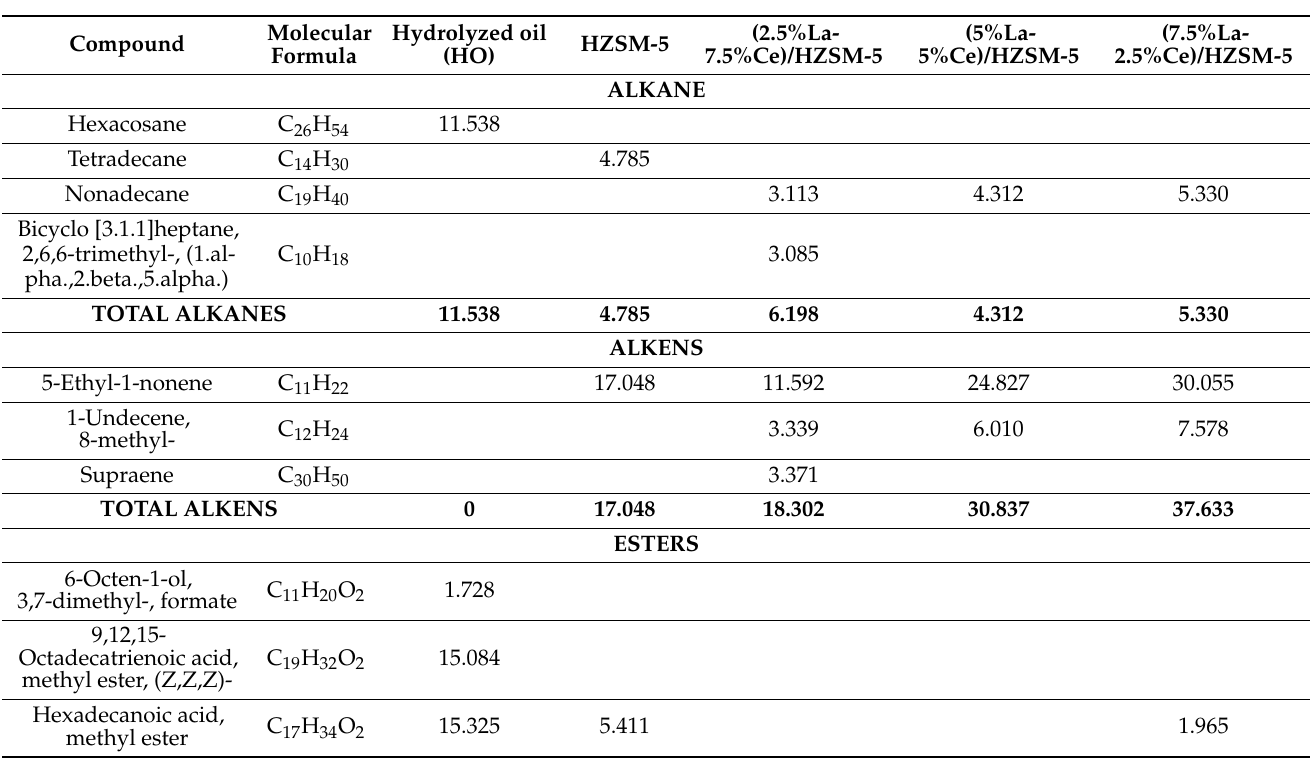
Figure 12. ( a ) The chemical composition groups of the algal HO and the liquid products from the catalytic deoxygenation of the algal HO for the parent HZSM-5 zeolite and Lanthanum-Cerium- modified HZSM-5 zeolite with different loading weight percentages (batch reactor, 300 ◦ C, 1000 rpm, 7 bar N 2 , catalyst-to-HO ratio = 15% (wt.%), and 6 h); ( b ) hydrocarbon yield percentage distribution with the surface area and micropore area of the synthesized catalysts; ( c ) hydrocarbon yield percentage distribution with the acidity of the synthesized catalysts. Table 5. The main components and content of the hydrolyzed oil (HO) and the products of catalytic deoxygenation for the HO for the parent HZSM-5 zeolite and Lanthanum-Cerium-modified HZSM-5 (initial pressure), catalyst-to-algal HO ratio = 15% (wt.%), and 6